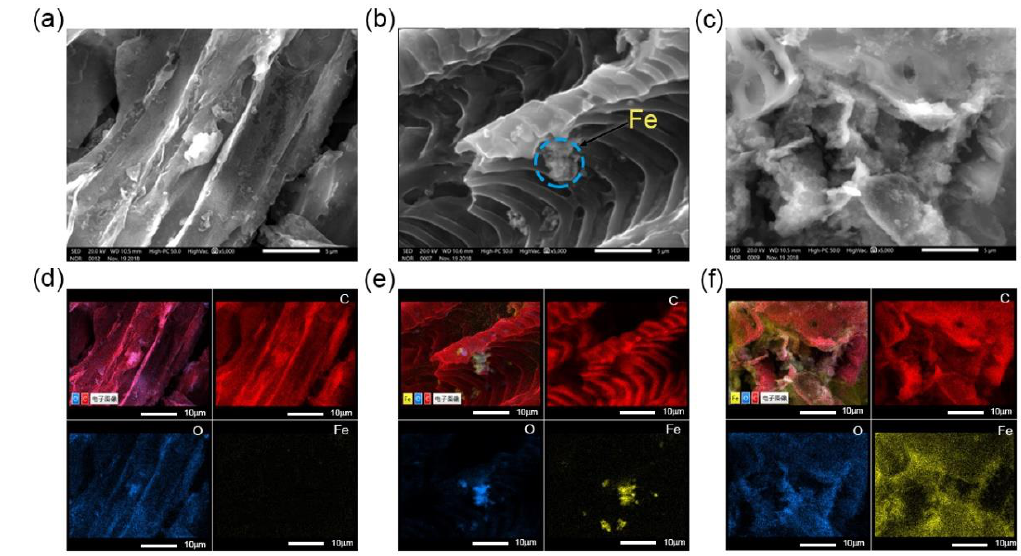
Figure 3. SEM microscopic images of as-prepared BC ( a ), nZVI–BC ( b ), and C–nZVI–BC ( c ). Scale bar = 5 µm. The element mapping indicated a distribution information of Fe (yellow), O (blue), and C (red) of the corresponding BC ( d ), nZVI – BC ( e ), and C – nZVI – BC ( f ). Scale bar: 10 µm.